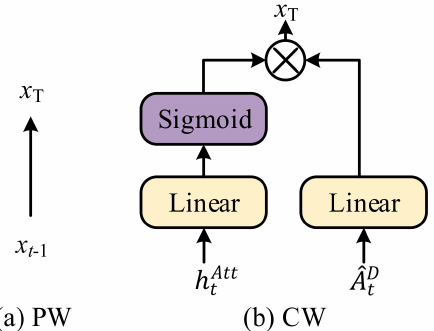
Figure 5. The illustration of PW and CW. ( a ) In PW, word information comes from the previous step and is applied briefly. ( b ) In CW, word information is provided from the current step attention LSTM and refined by linear transformation and